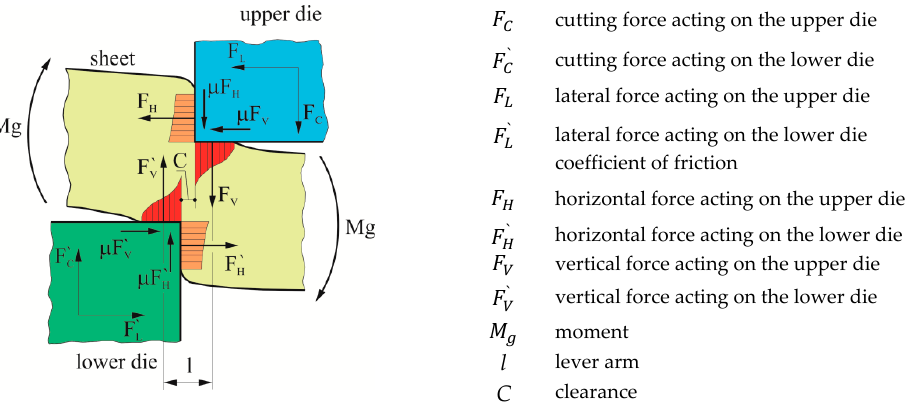
Figure 1. The system of forces and pressures during punching.